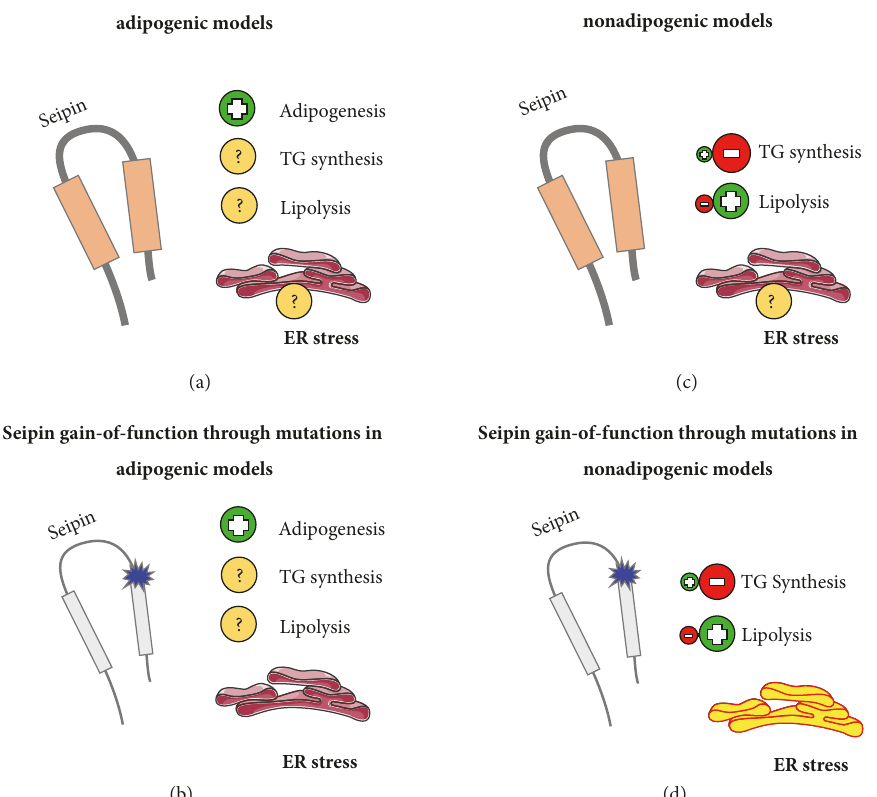
Figure 5: S eipin gain-of-function. We are proposing 4 different general models that usually happen with frequency under seipin gain- of-function. (a) Seipin gain-of-function through overexpression in adipogenic models. Adipocyte maturation was not impaired, but other parameters are still not clear. (b) Seipin gain-of-function through mutations in adipogenic models. Adipocyte maturation was not impaired even with ER stress. (c) Seipin gain-of-function through overexpression in nonadipogenic models. There was TG synthesis decrease, with lipolysis increase. (d) Seipin gain-of-function through mutations in nonadipogenic models. TG synthesis impairment was observed together with lipolysis increaseand strong and significant ER stress. (b) and (d) models arerelatedtoseipinopathy. Positive symbols representa process that is usually increased, while the negative symbols represent the opposite. The interrogation symbol represents a process that needs to be studied further. Pieces of the illustrations are from the SMART website